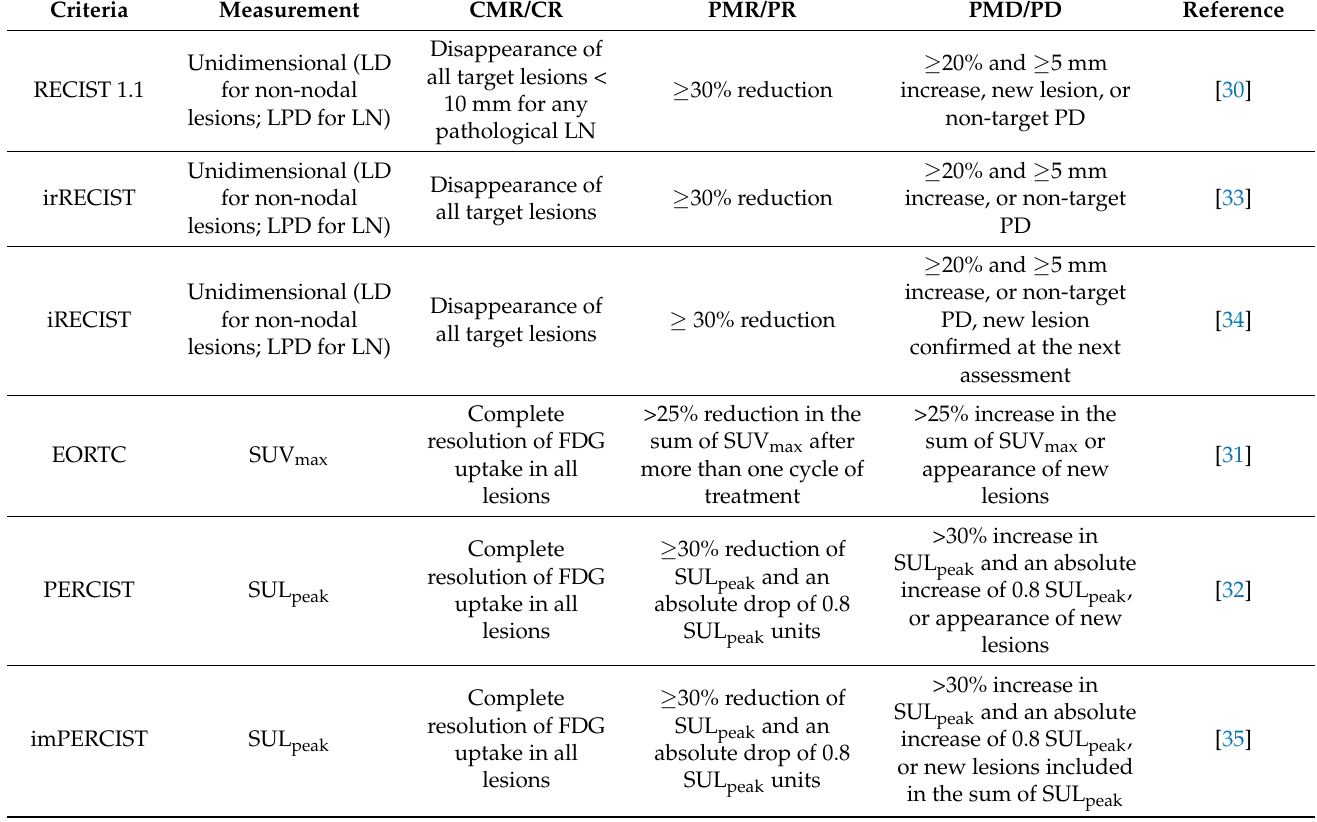
Table 1. Conventional/immune-related response evaluation criteria and response evaluation criteria using FDG-PET for solid